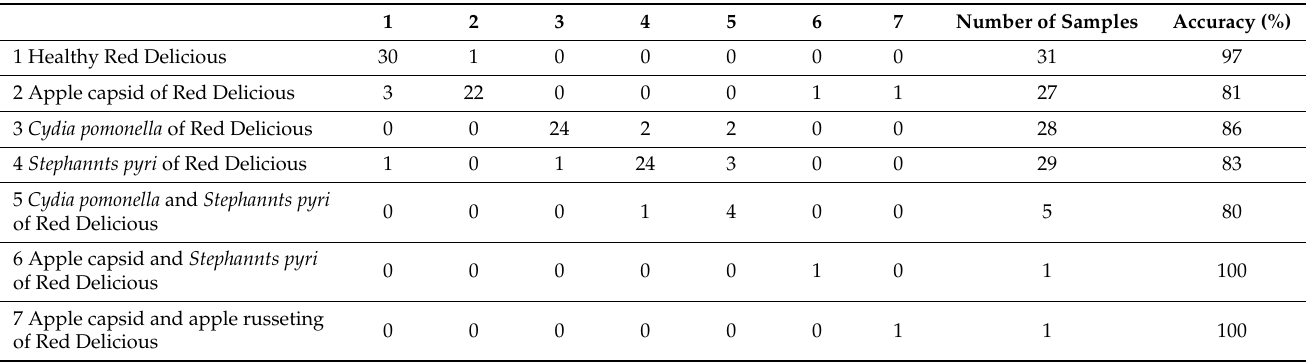
Table 4. Confusion matrix and data classification using sparse coding with three views of Red Delicious apples.